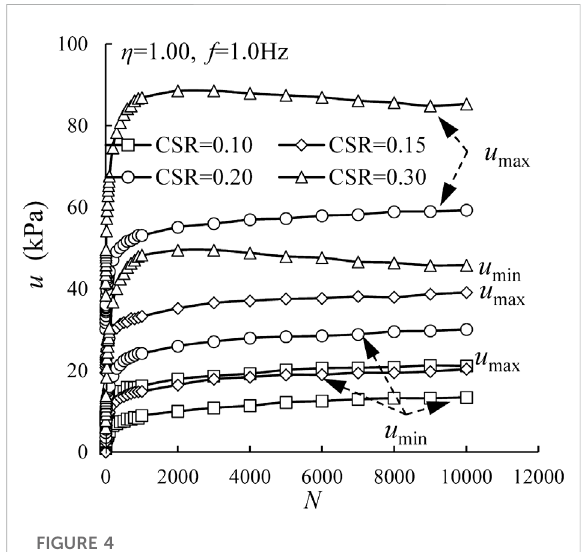
FIGURE 4 Variations of excess pore water pressure with number of cycles under different CSRs for f = 1.0 Hz and η =